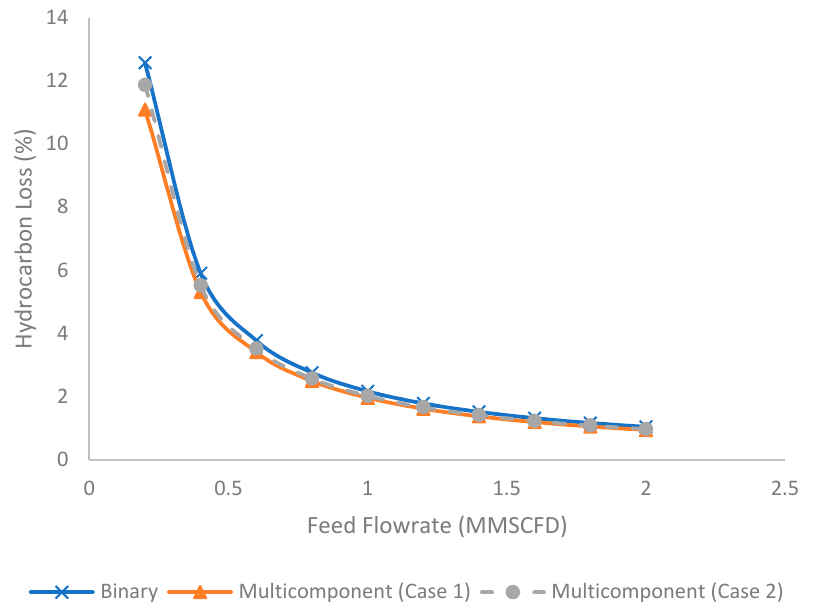
15 of 22 Figure 9. Evolution of stage cut under different feed flow rates for binary and multicomponent sys- tems. Figure 10 represents the evolution of hydrocarbon loss (%) at different feed flow rates for binary and multicomponent systems. The increase in feed flow rate tended to reduce